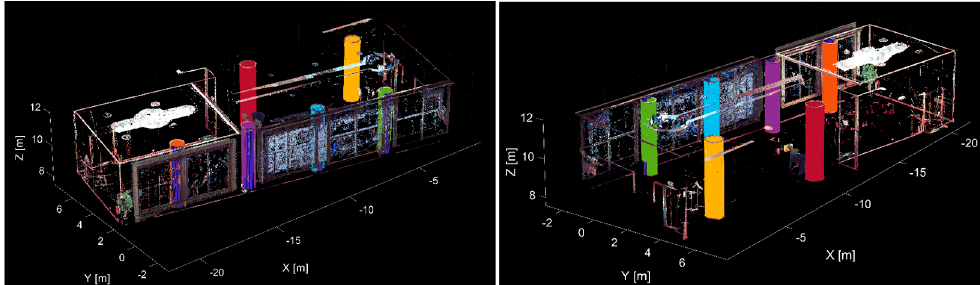
Figure 10. The remaining point cloud with the segmented cylinders.